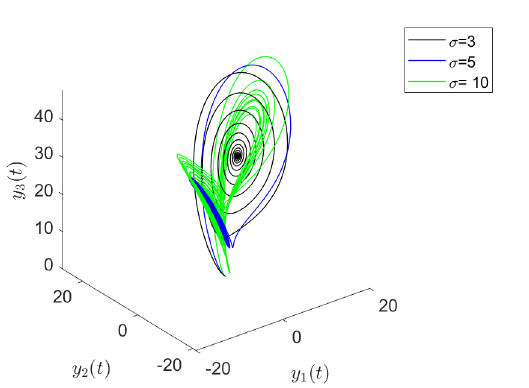
Figure 23. Phase portraits of y 1 , y 2 and y 3 when varying ρ .